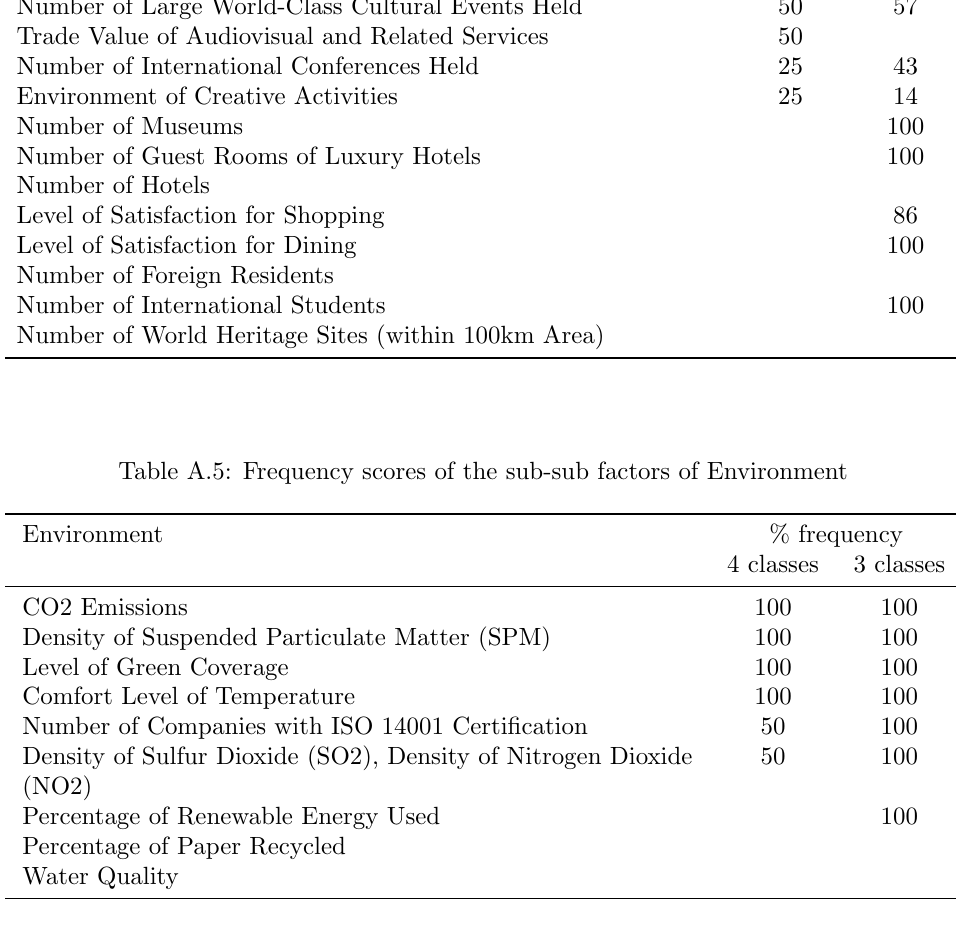
Table A.4: Frequency scores of the sub-sub factors of Cultural Interaction Cultural Interaction % frequency